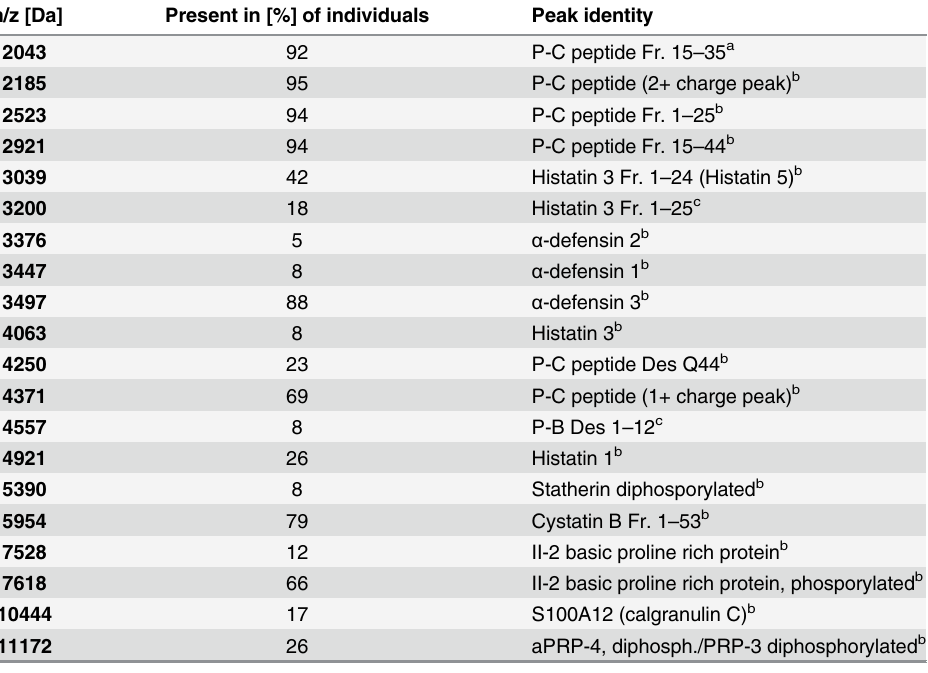
Table 1. Putative identities for peaks in the MALDI-TOF MS spectra of saliva from healthy volunteers. m/z [Da] Present in [%] of